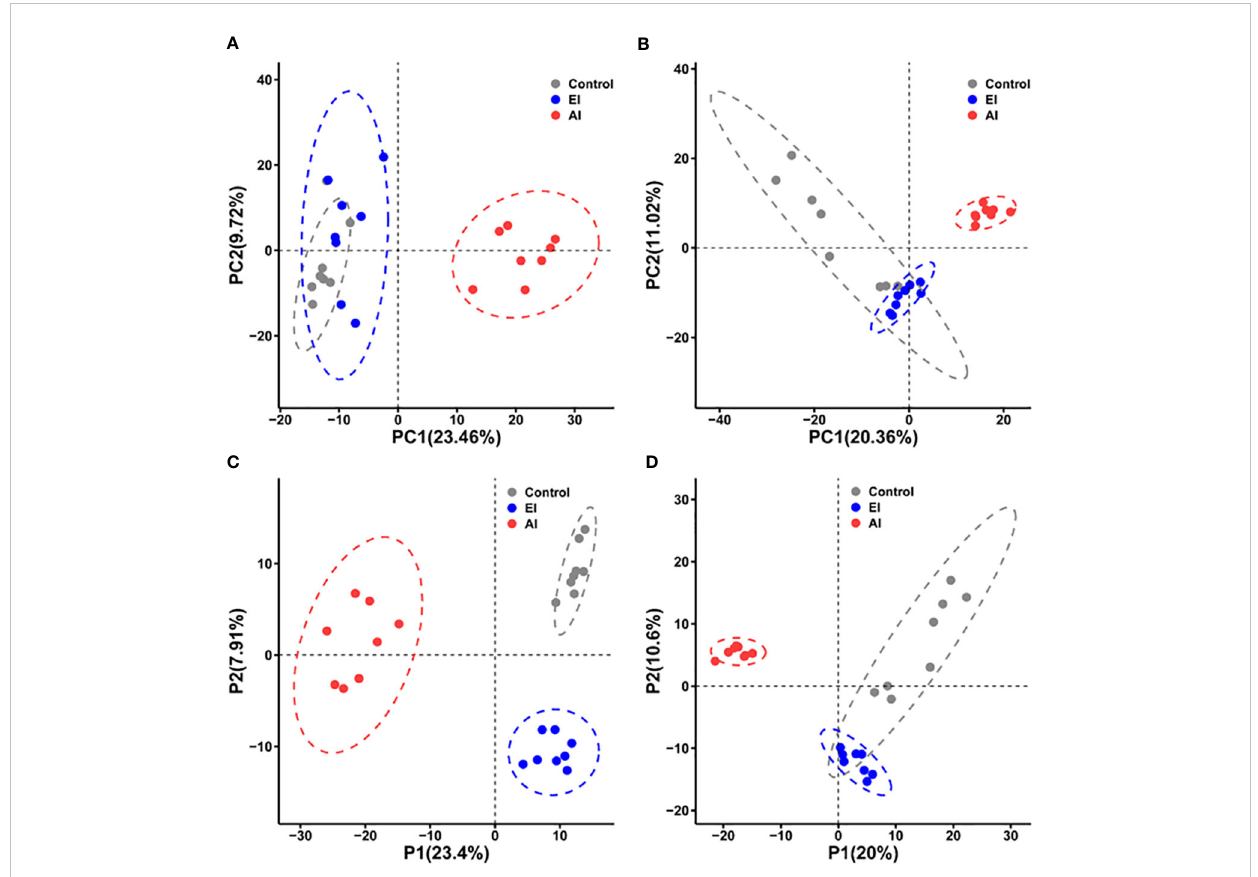
FIGURE 2 Differential metabolic pro fi les of mouse serum during B. microti infection. (A, B) Principal component analysis (PCA) score scatter plots of metabolites obtained through LC − MS in ESI − mode (A) and ESI+ mode (B) . (C, D) Partial least squares discriminant analysis (PLS-DA) separation of the metabolites presents in the three groups in ESI − mode (C) and ESI+ mode (D) . EI, early infected group; AI, acutely infected group; Ctrl, noninfected